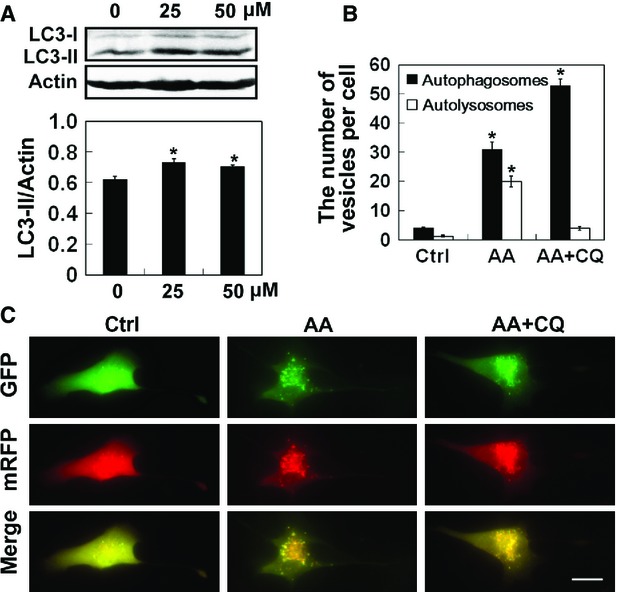
Autophagy flux in cells exposed to aurantiamide acetate. (A) U87 cells were incubated with 0, 25 or 50 μM aurantiamide acetate (AA). The expressions of LC3-I and LC3-II in cells were examined by Western blotting. Actin was used as internal control. Data were quantified from three independent experiments. (B and C) U87 cells transfected with mRFP-GFP-LC3 were exposed to AA or AA plus 10 μM chloroquine (AA+CQ). The fluorescence was examined under fluorescent microscope. GFP (sensitive to acidification and lysosomal degradation)-labelled vesicles were autophagosomes; mRFP (insensitive to acidification and lysosomal degradation)-labelled vesicles were autophagosomes and autolysosomes; vesicles expressing only mRFP were autolysosomes. (G) The number of autophagosomes and autolysosomes per cell was calculated; scale bars, 20 μm. *P < 0.05 compared with control.